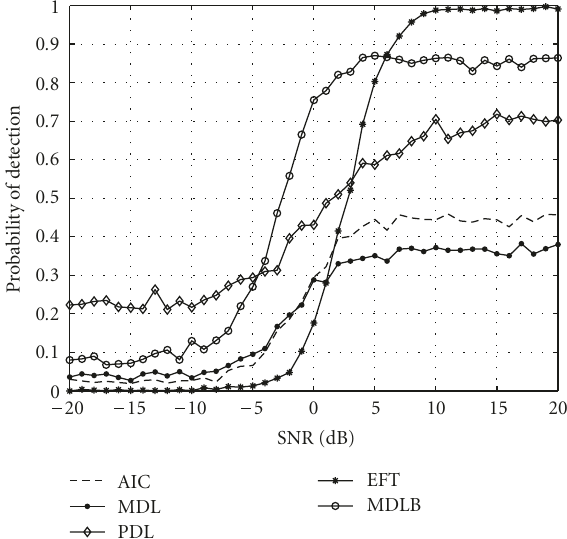
Figure 5: Probability of detection for the EFT (predefined P fa = 10%), the MDL, the AIC, the PDL, and the MDLB.